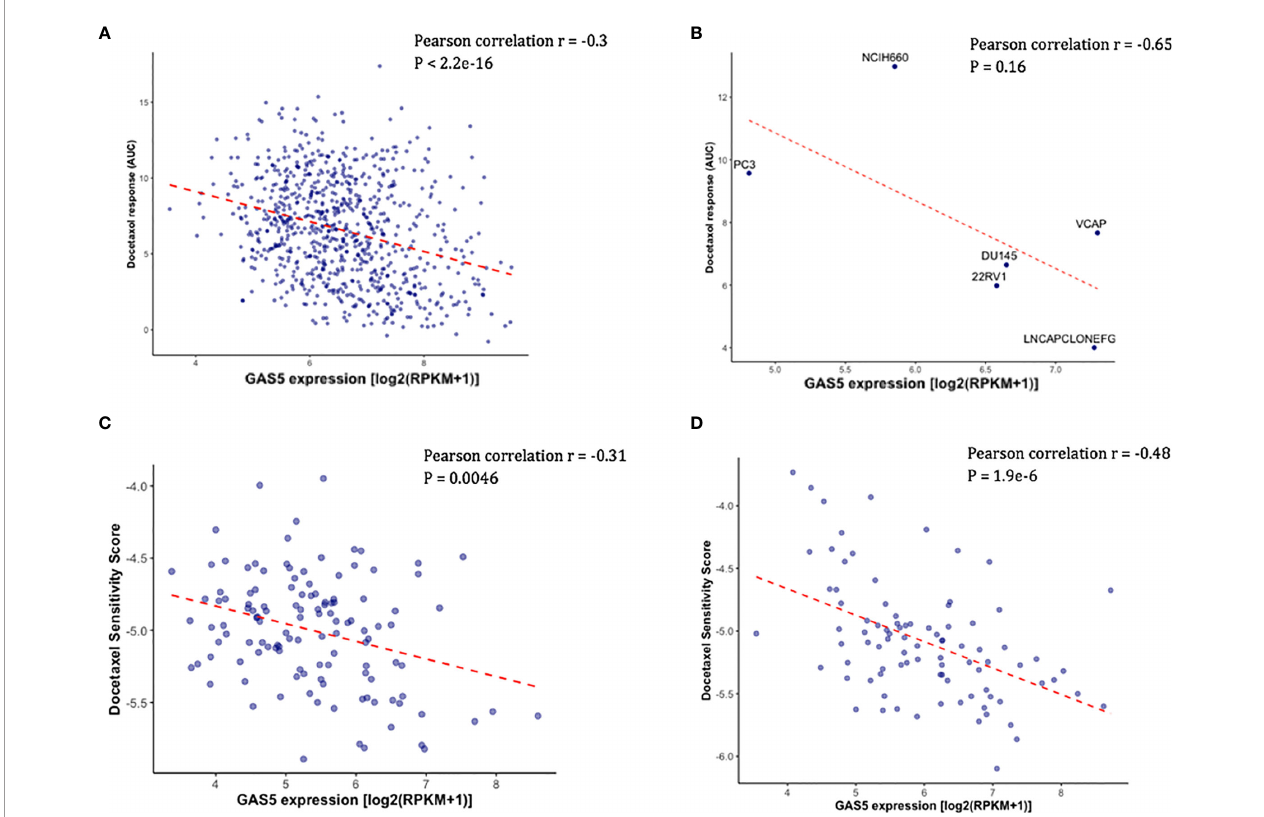
FIGURE 1 | Higher GAS5 expression was associated with higher docetaxel sensitivity in cancer cell lines and CRPC patients. Lower imputed docetaxel sensitivity score indicates higher sensitivity in CRPC patients. (A) Scatter plot showing docetaxel response (AUC) (Y-axis) and GAS5 expression in 811 cancer cell lines in CTRPv2. (B) Scatter plot showing docetaxel response (AUC) (Y-axis) and GAS5 expression in 6 PCa cell lines. Name of the cell line was identi fi ed above the corresponding point. (C) Scatter plot showing imputed docetaxel sensitivity score (Y-axis) and measured GAS5 expression in 117 CRPC patients in SU2C clinical study. (D) Scatter plot showing imputed docetaxel sensitivity score (Y-axis) and measured GAS5 expression in 91 CRPC patients in PROMOTE